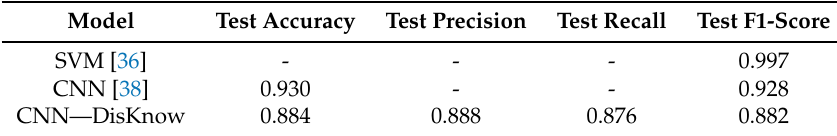
Table 2. Comparative results of the event type classification task.